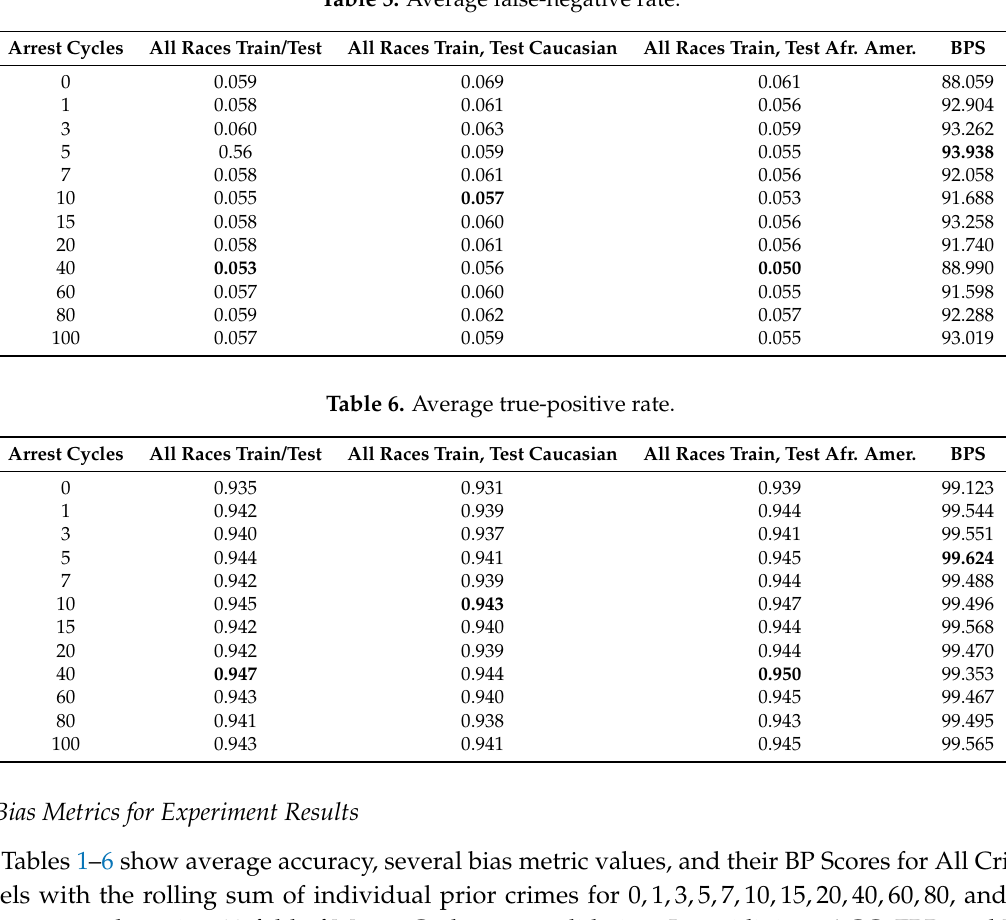
Table 5. Average false-negative rate.